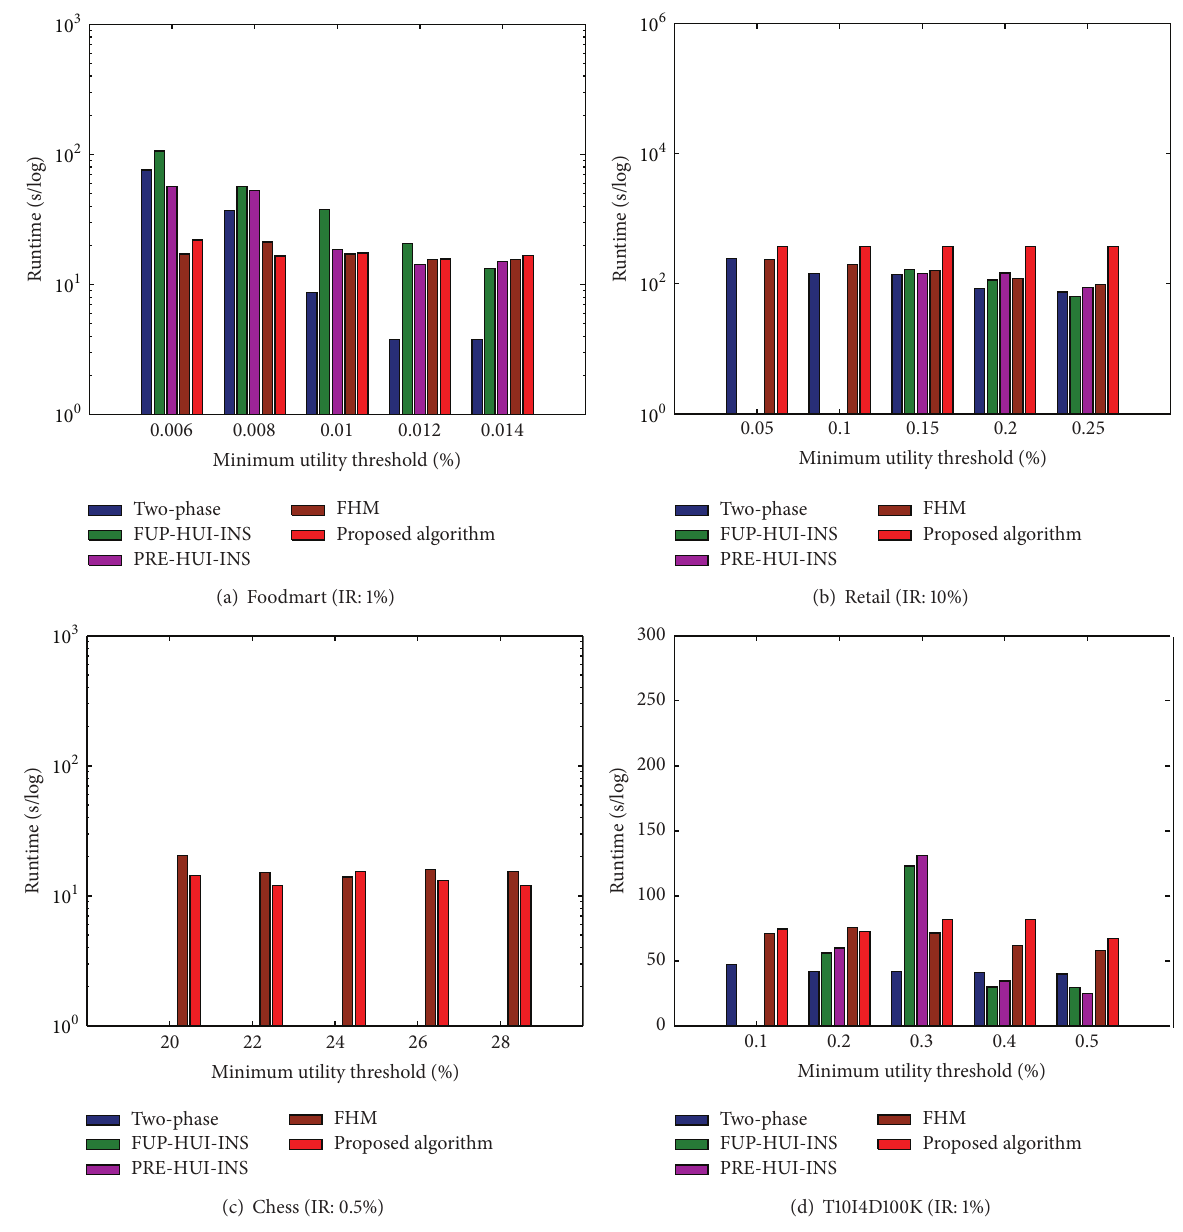
Figure 8: Memory consumption under various minimum utility